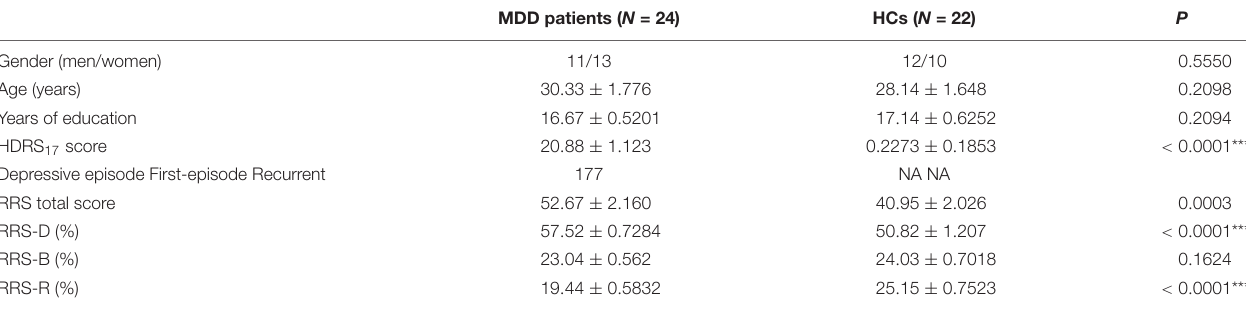
TABLE 1 | Demographics and clinical characteristics of the participants.